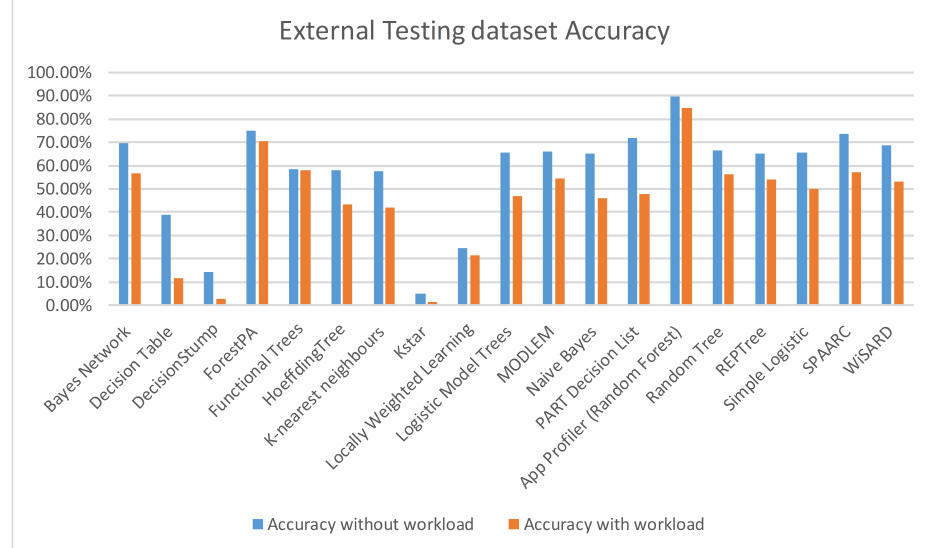
Figure 8. Accuracy of classification algorithms with the external